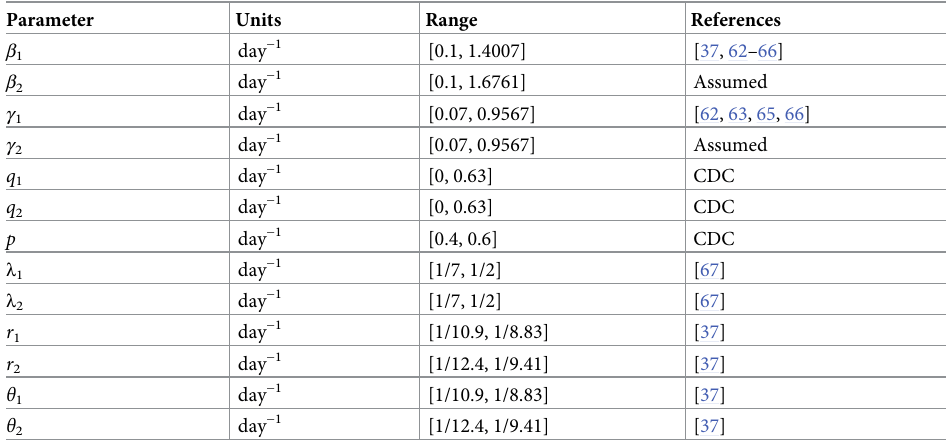
Table 3. Model parameter